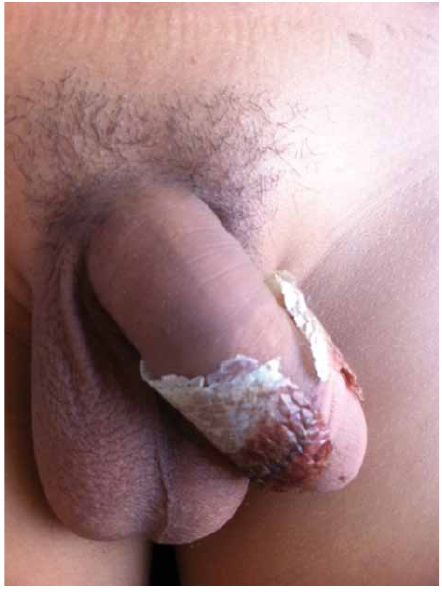
Figure 6 - Spontaneous loss of the biopolymer tape after the 10 th